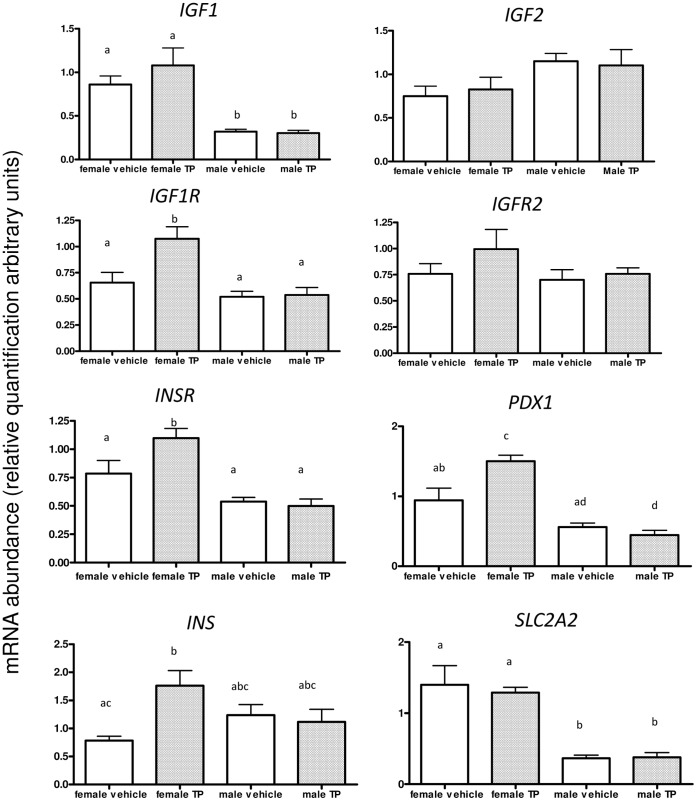
Fetal pancreatic expression of key developmental genes and in vitro insulin secretion is dependent upon fetal sex and timing of exposure to excess androgens.
A:
Female fetuses: At d90, (vehicle n = 5, MI-TP n = 8), d62 MI-TP significantly increased expression of IGF1R (P<0.05), PDX1 (P<0.01), INSR (P<0.05) and INS (P<0.05) mRNA. Male fetuses: Whilst there were differences in expression attributable to the sex of the fetuses (see results section for full description), there were no differences in expression of any genes studied attributable to in utero treatment in male fetuses studied at d90 (vehicle n = 6, MI-TP n = 6) of gestation. Different superscripts denote significant differences (P<0.01–0.05, see results sections for full details).